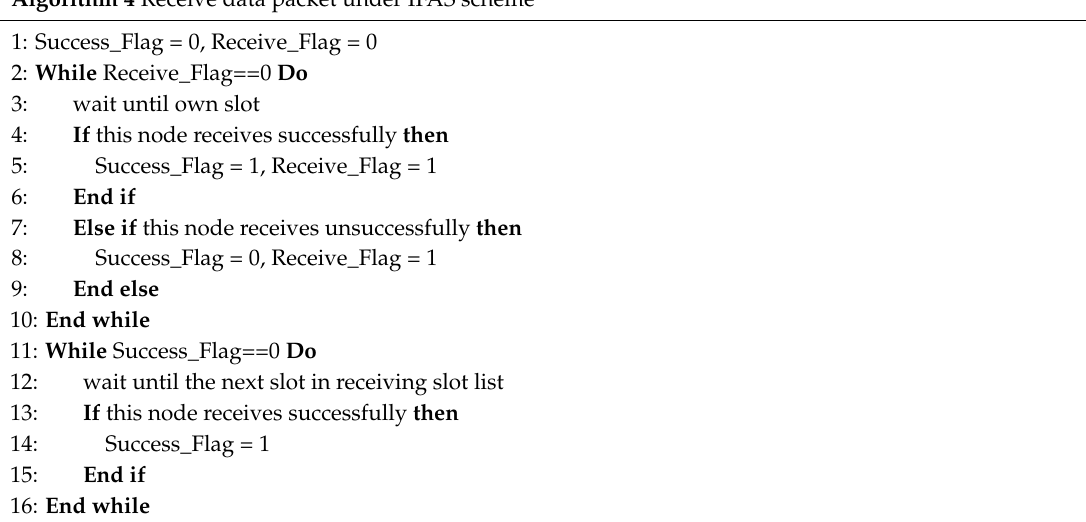
Algorithm 4 Receive data packet under IFAS